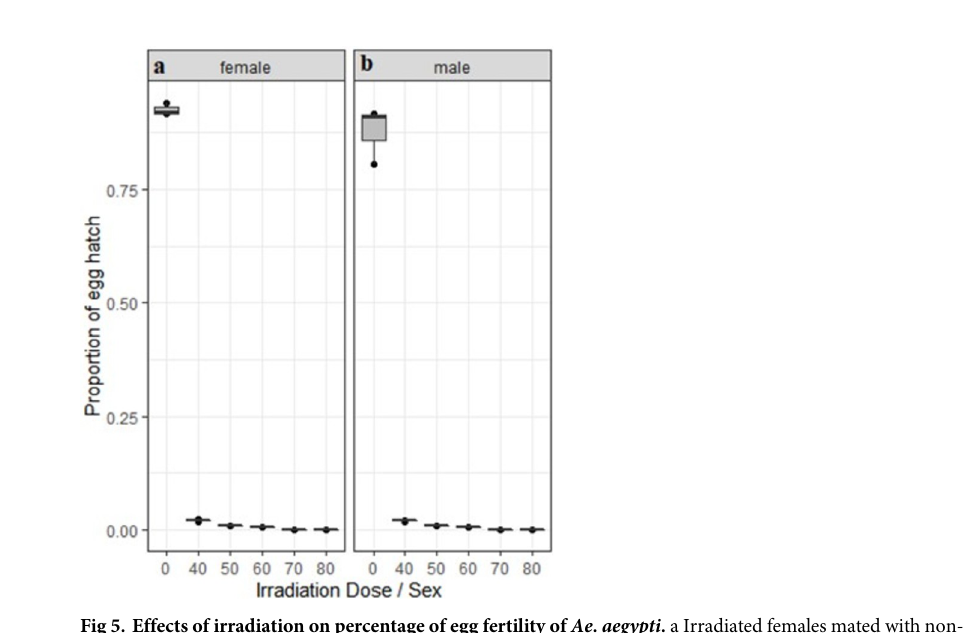
PLOS ONE | https://doi.org/10.1371/journal.pone.0265244 April 4,